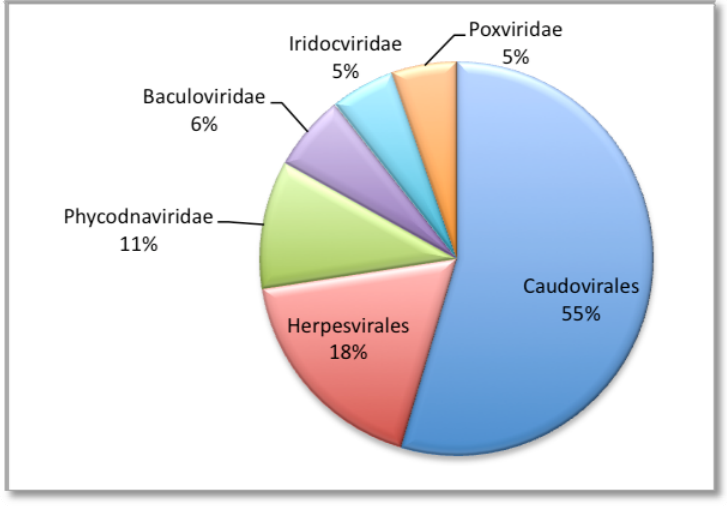
Figure 4. Percentage of sequences assigned to the dsDNA